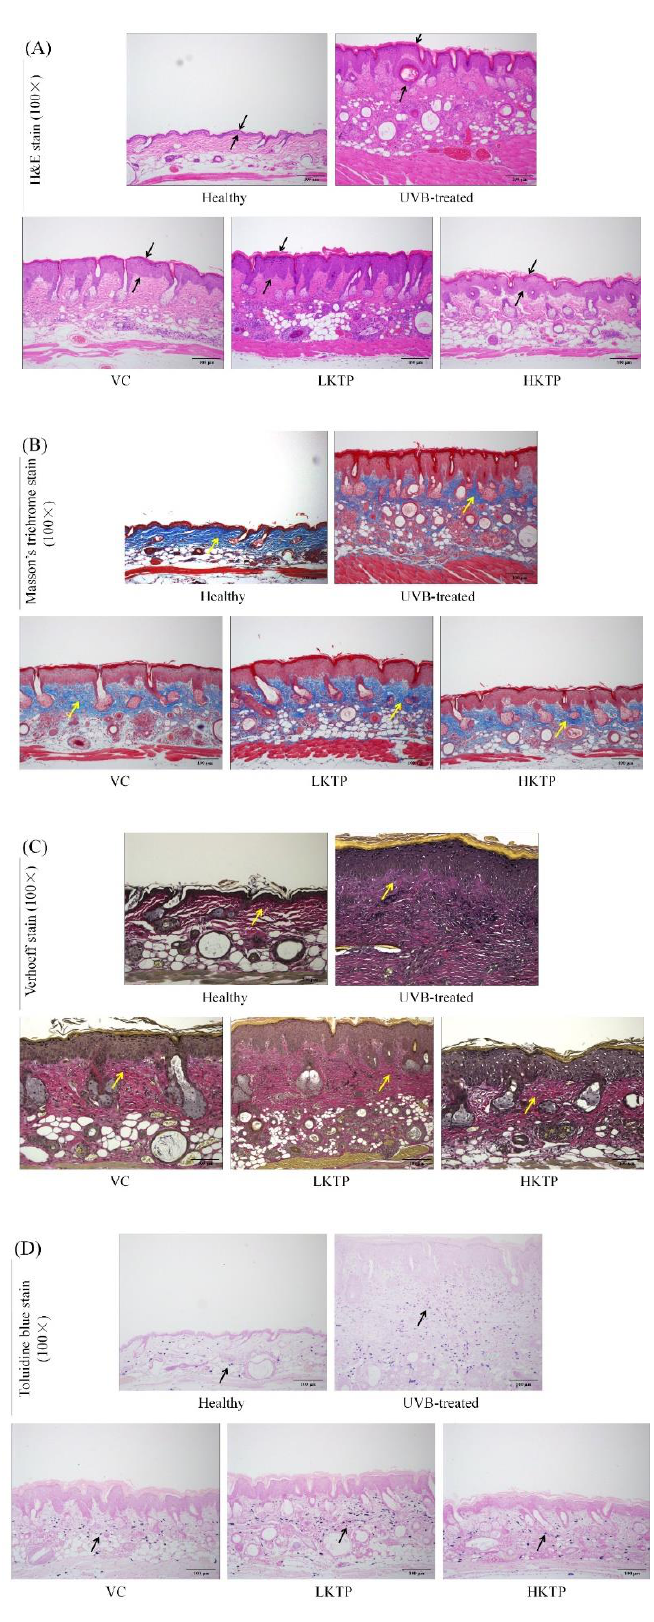
Figure 3. H & E ( A ), Masson’s trichrome ( B ), Verhoeff ( C ), and toluidine blue ( D ) staining of skin tissue in SKH1 hairless mice with UVB-induced skin aging. VC: mice were smeared with 5.0% VC solution; LKTP: mice were smeared with 2.5% polyphenols of Kuding tea; and HKTP: mice were smeared with 5.0% polyphenols of Kuding tea. Magnification 100×.